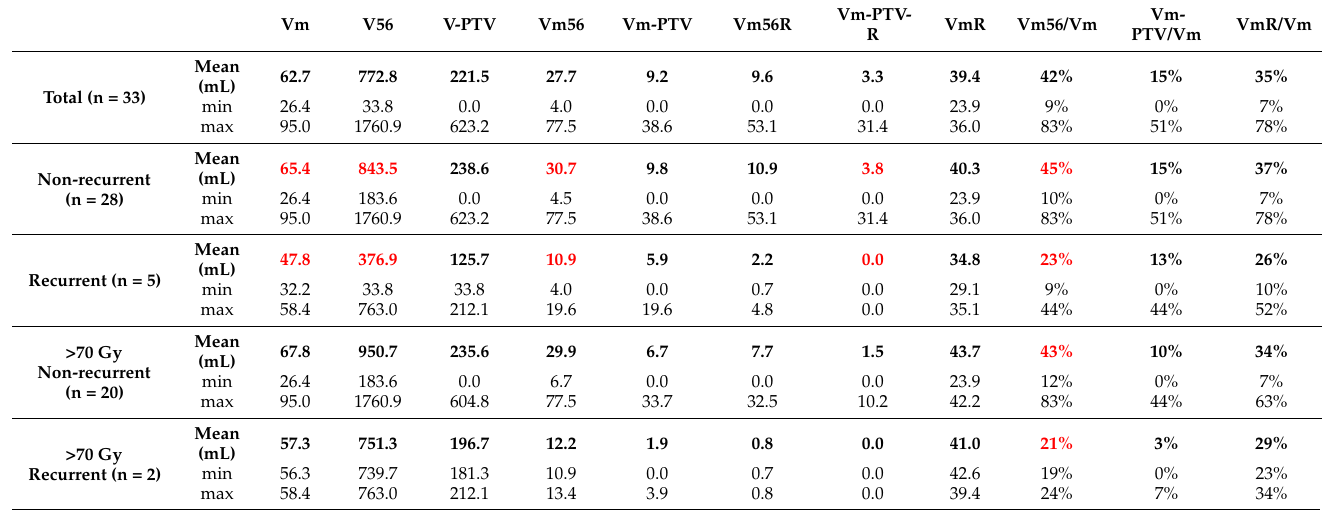
Table 2. Mean, minimum and maximum volumes of mandible and RT isodose fields. Volume